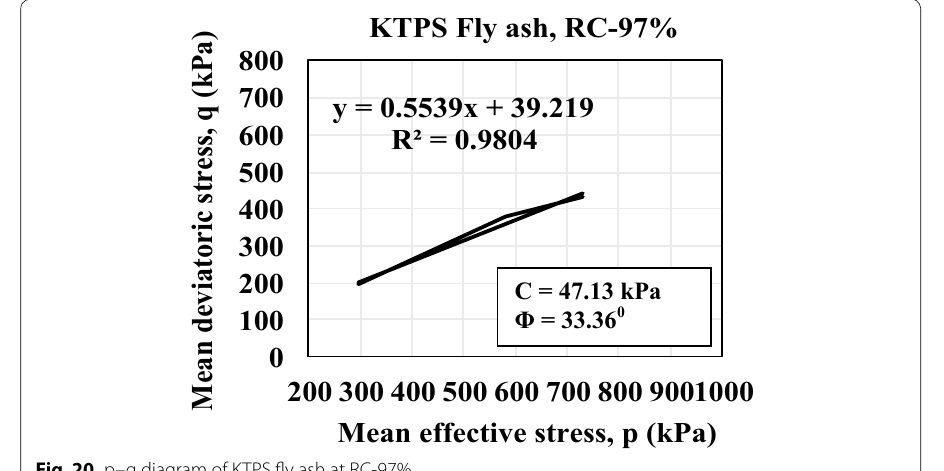
Fig. 20 p–q diagram of KTPS fly ash at RC-97%